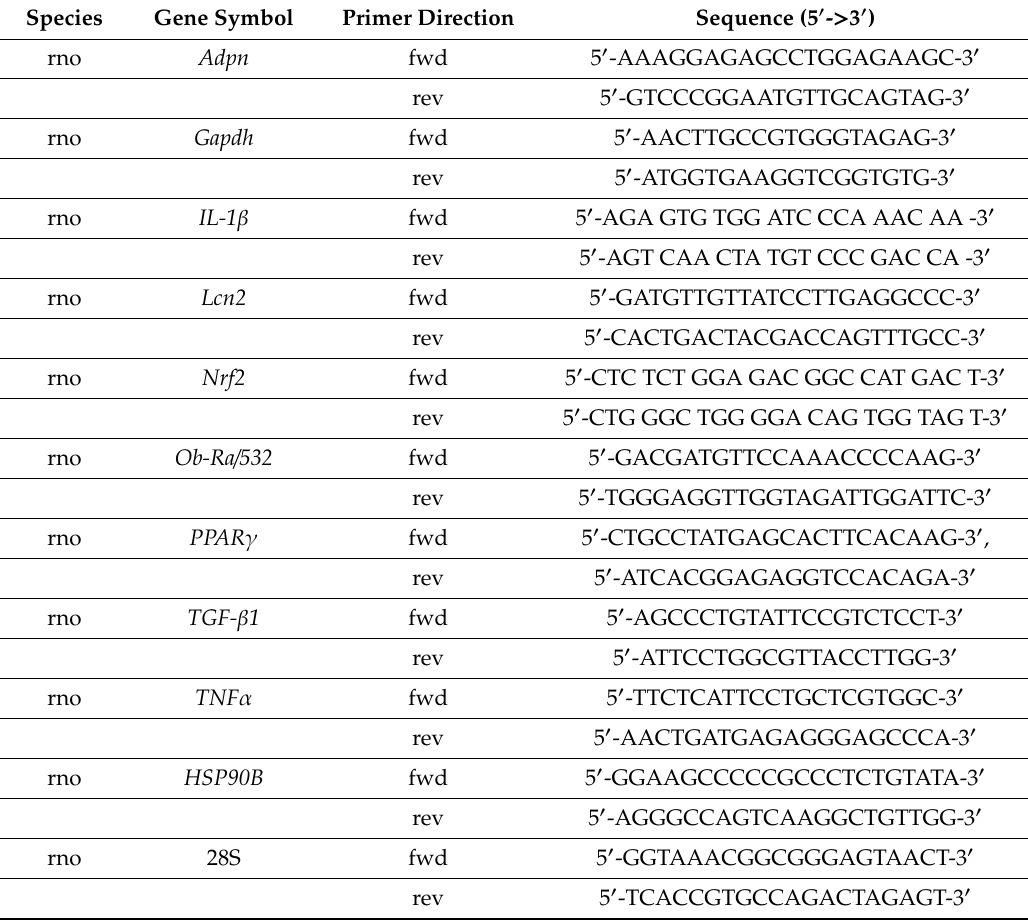
Table 1. qPCR Primer